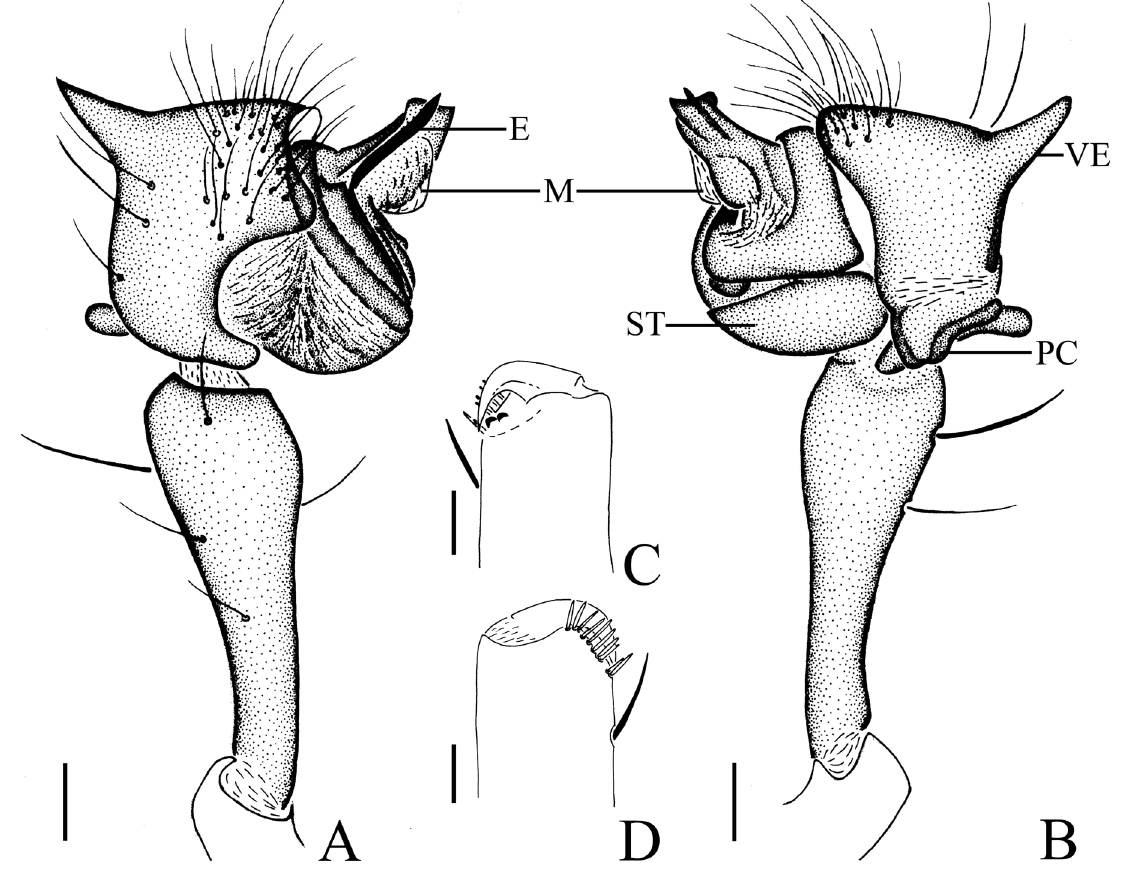
Fig. 2. Mimetus bucerus sp. nov. A – D . Holotype, ♂ (GZ-MIM-2017-005). A . Palp, prolateral view. B . Palp, retrolateral view. C . Left chelicerae of male,ventral view. D . Left chelicerae, dorsal view. Scale bars: 0.1